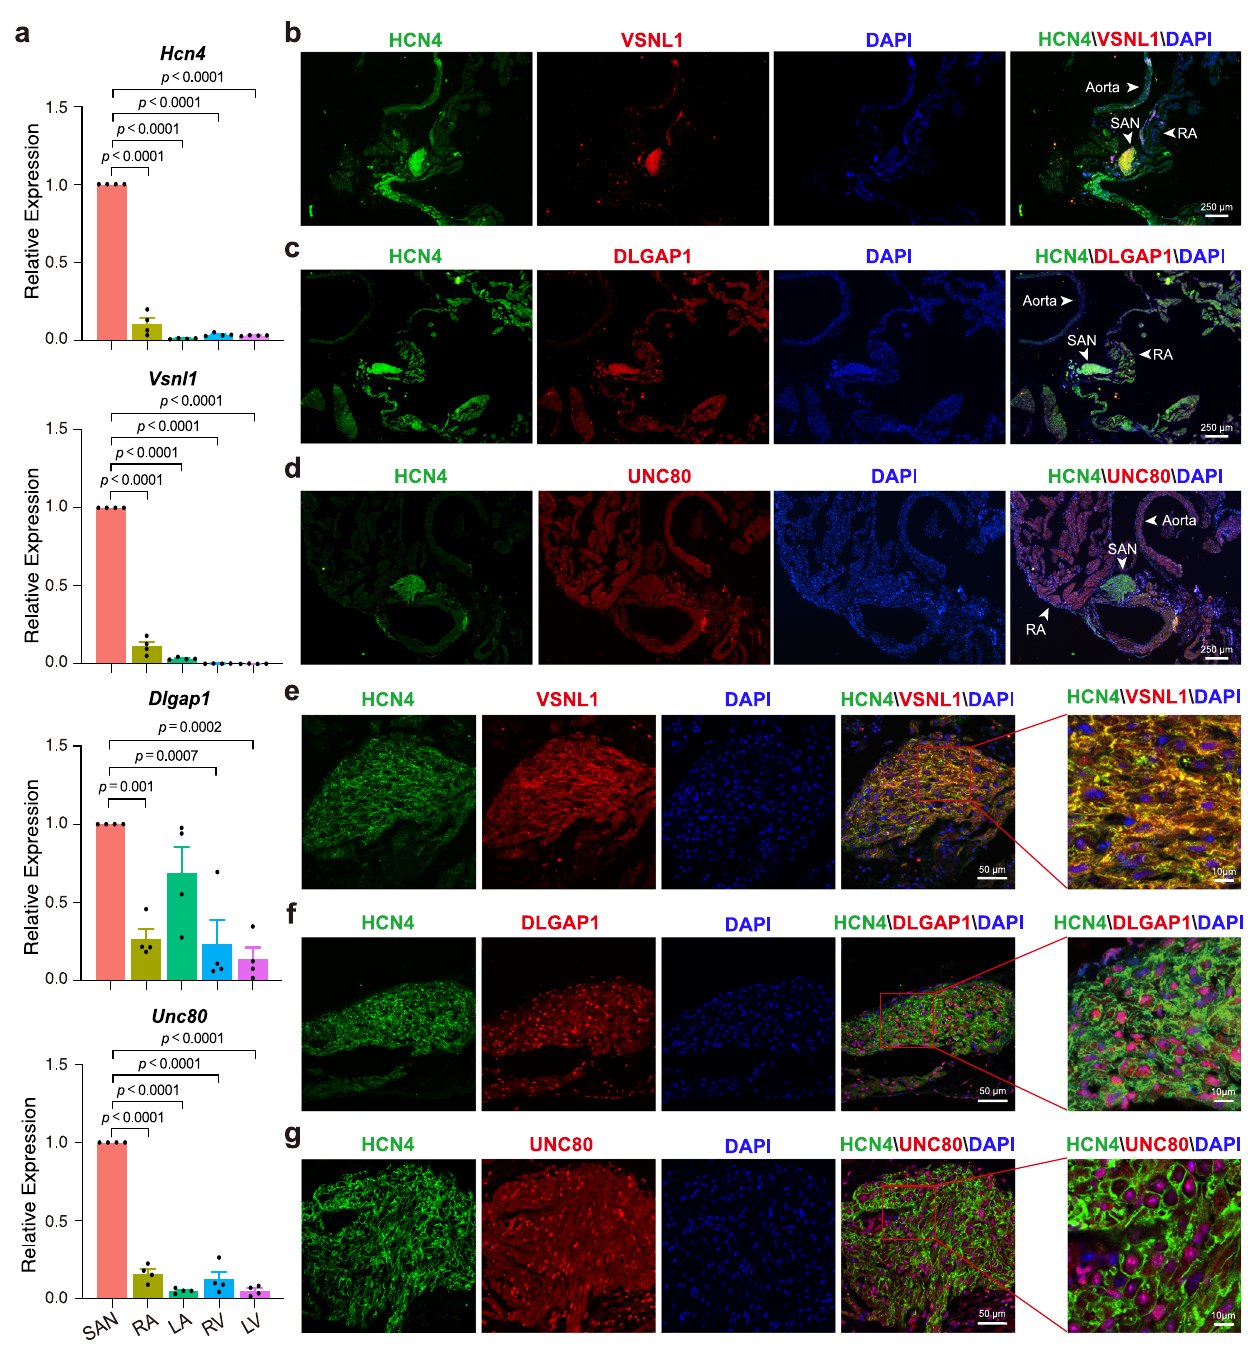
Fig. 2 Expression pattern of the core cluster markers Vsnl1 , Dlgap1 , and Unc80 in mouse heart. a qPCR analysis shows the expression of Hcn4, Vsnl1, Dlgap1, and Unc80 in sinoatrial node (SAN), atrial, and ventricular tissue, respectively ( n = 4 biologically independent animals per group), Dunnett ’ s multiple comparisons test, data are represented as mean ± s.e.m., adjusted p value was labeled on the top. RA right atrium, LA left atrium, RV right ventricle, LV left ventricle. b – g Immunohistochemical analysis of VSNL1, DLGAP1, and UNC80 in SAN slices at low magni fi cation. Representative images are shown from n = 3 biologically independent samples. b Immuno fl uorescence images of HCN4 (green), VSNL1 (red), and DAPI (blue). c Immuno fl uorescence images of HCN4 (green), DLGAP1 (red), and DAPI (blue). d Immuno fl uorescence images of HCN4 (green), UNC80 (red), and DAPI (blue). b – d The arrows indicate the tissues surrounding the SAN. Scale bar = 250 μ m. e – g Localization of the VSNL1, DLGAP1, and UNC80 within SAN at high magni fi cation. e Immuno fl uorescence images of HCN4 (green), VSNL1 (red), and DAPI (blue). f Immuno fl uorescence images of HCN4 (green), DLGAP1 (red), and DAPI (blue). g Immuno fl uorescence images of HCN4 (green), UNC80 (red), and DAPI (blue). Scale bar = 50 μ m. e – g Zoom images (the red box regions in the merged image) show the higher magni fi cation. Scale bar = 10 μ